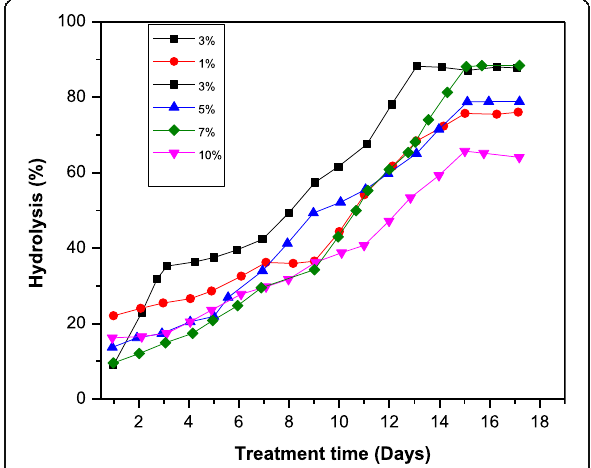
Fig. 5 Percentage of sugar released after microbial hydrolysis for 1, 3, 5, 7, and 10% NaOH pretreated rice